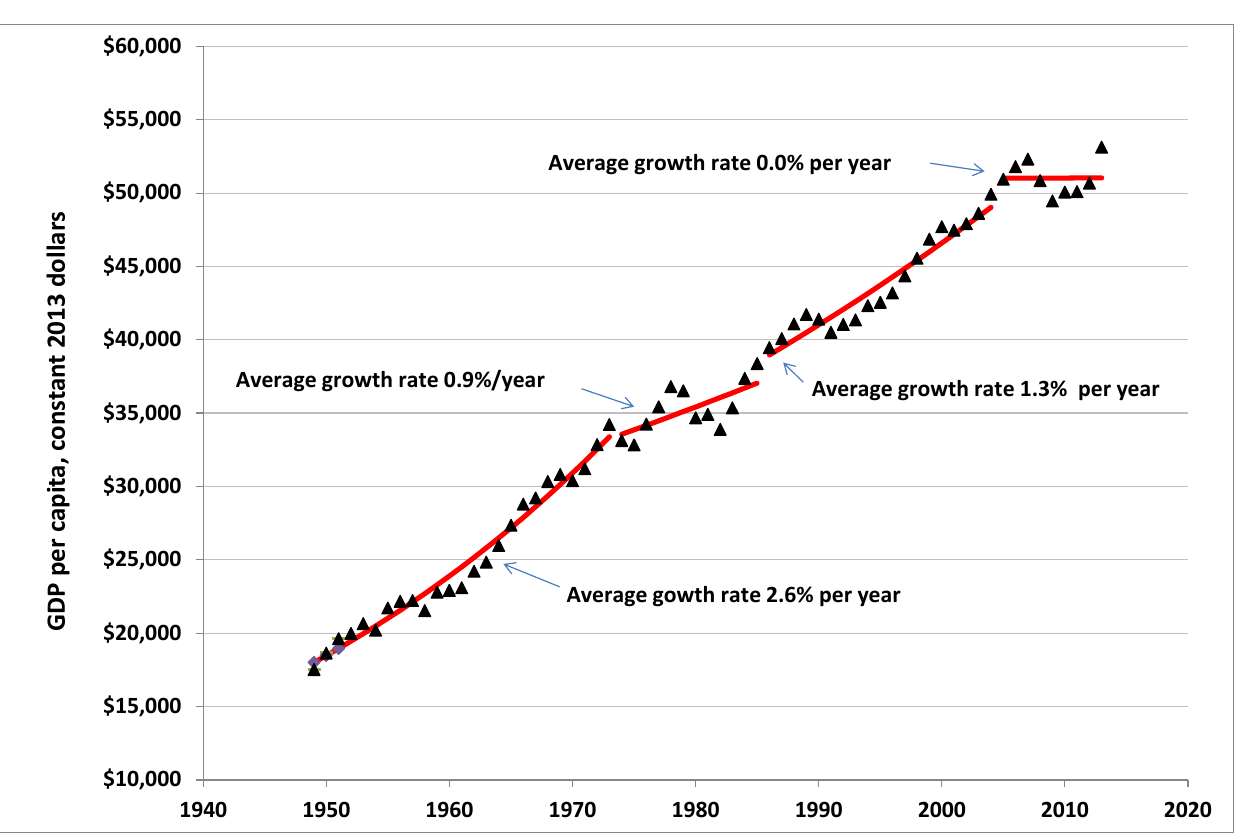
Figure 1. Growth of U.S. economy, 1949 through 2013; GDP per capita and best-fitting exponential trend lines, four